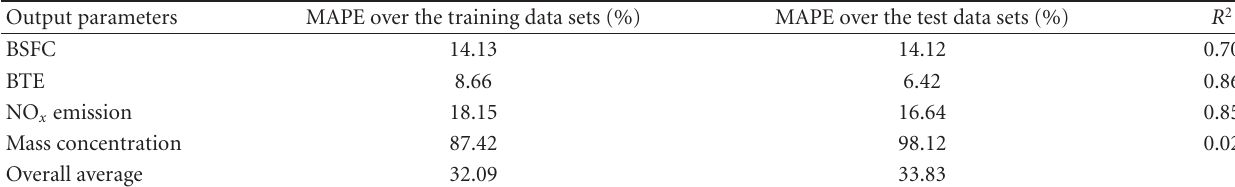
Table 5: Results of the ANN